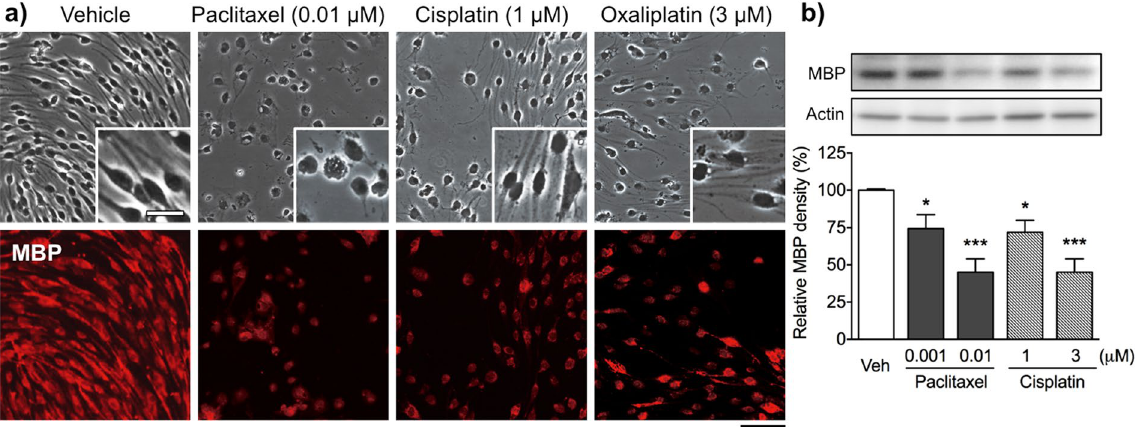
Figure 3. Effects of paclitaxel, cisplatin and oxaliplatin on Schwann cell morphology and MBP expression. ( a ) Phase ( upper ) and fluorescence ( lower ) micrographs of differentiated Schwann cells labeled with an anti-MBP antibody. Differentiated Schwann cells were treated with vehicle (0.1% DMSO), paclitaxel (0.01 μ M), cisplatin (1 μ M) or oxaliplatin (3 μ M) for 48 h. Cisplatin and oxaliplatin reduced the number of MBP-positive Schwann